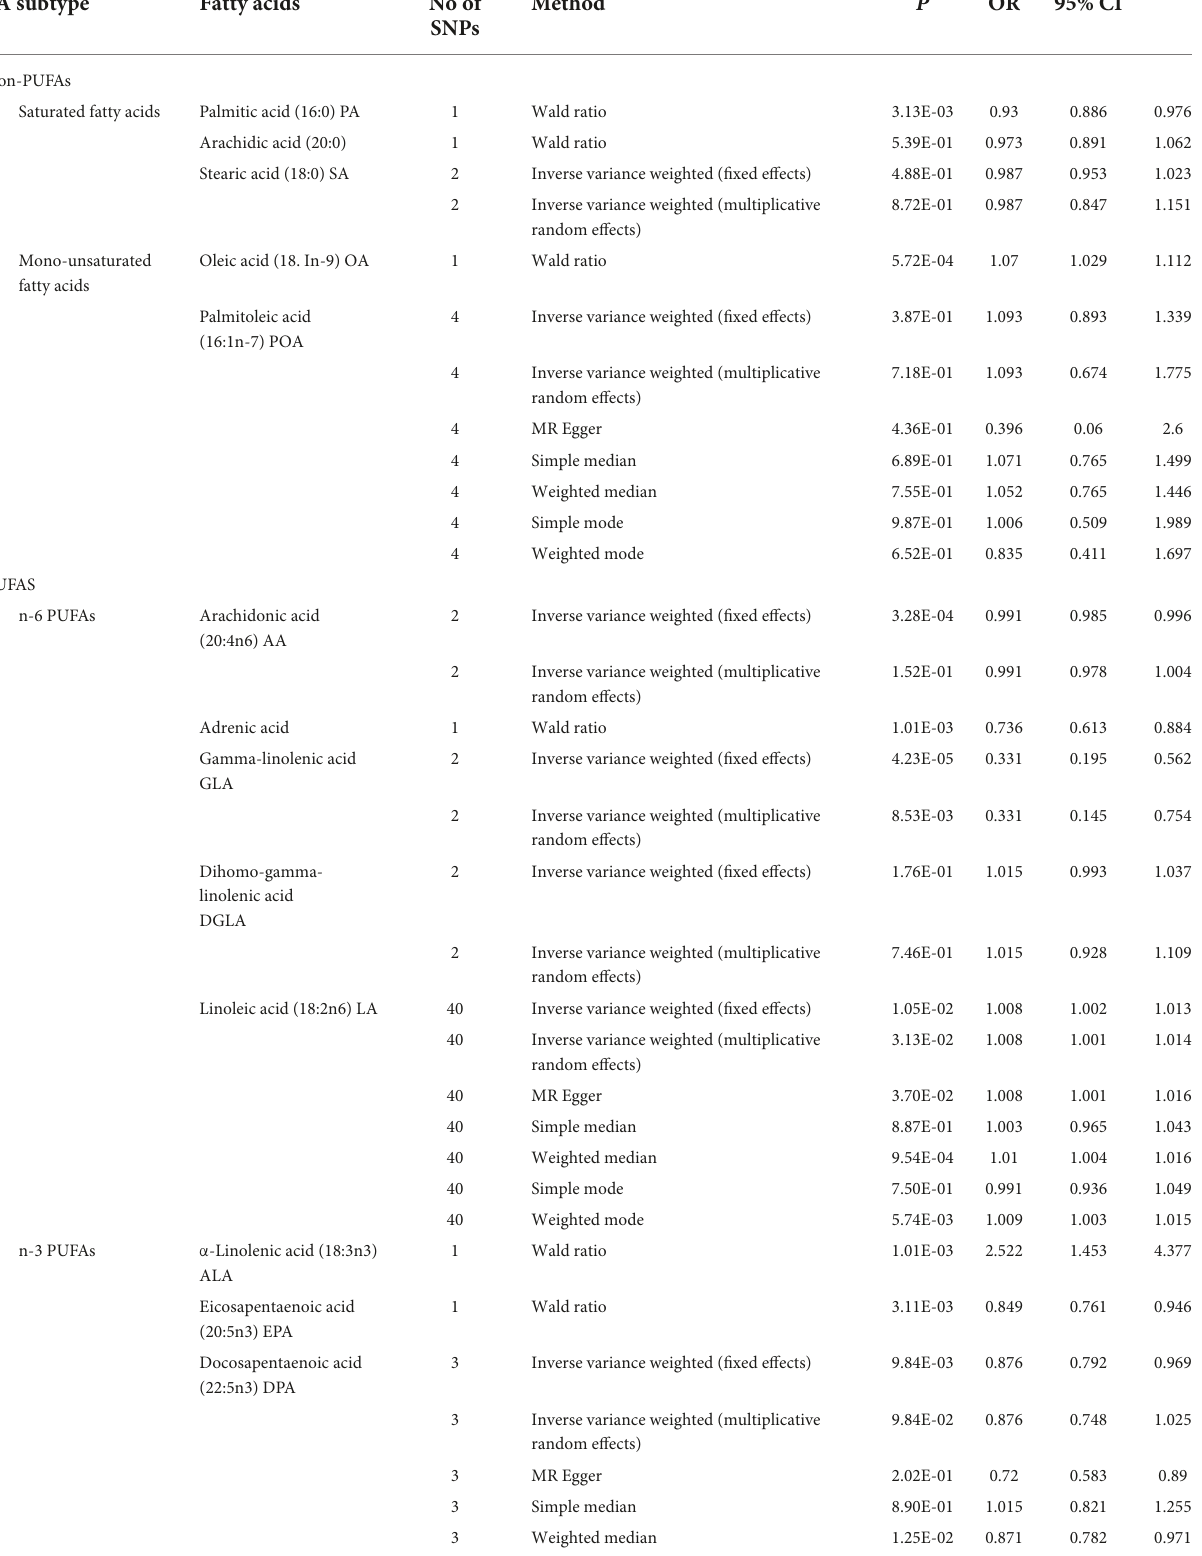
TABLE 2 Associations of plasma fatty acid levels with risk of depression in Mendelian randomization analyses (Wald ratio, multiplicative random effects inverse-variance weighted model fixed-effects inverse-variance weighted model). FA